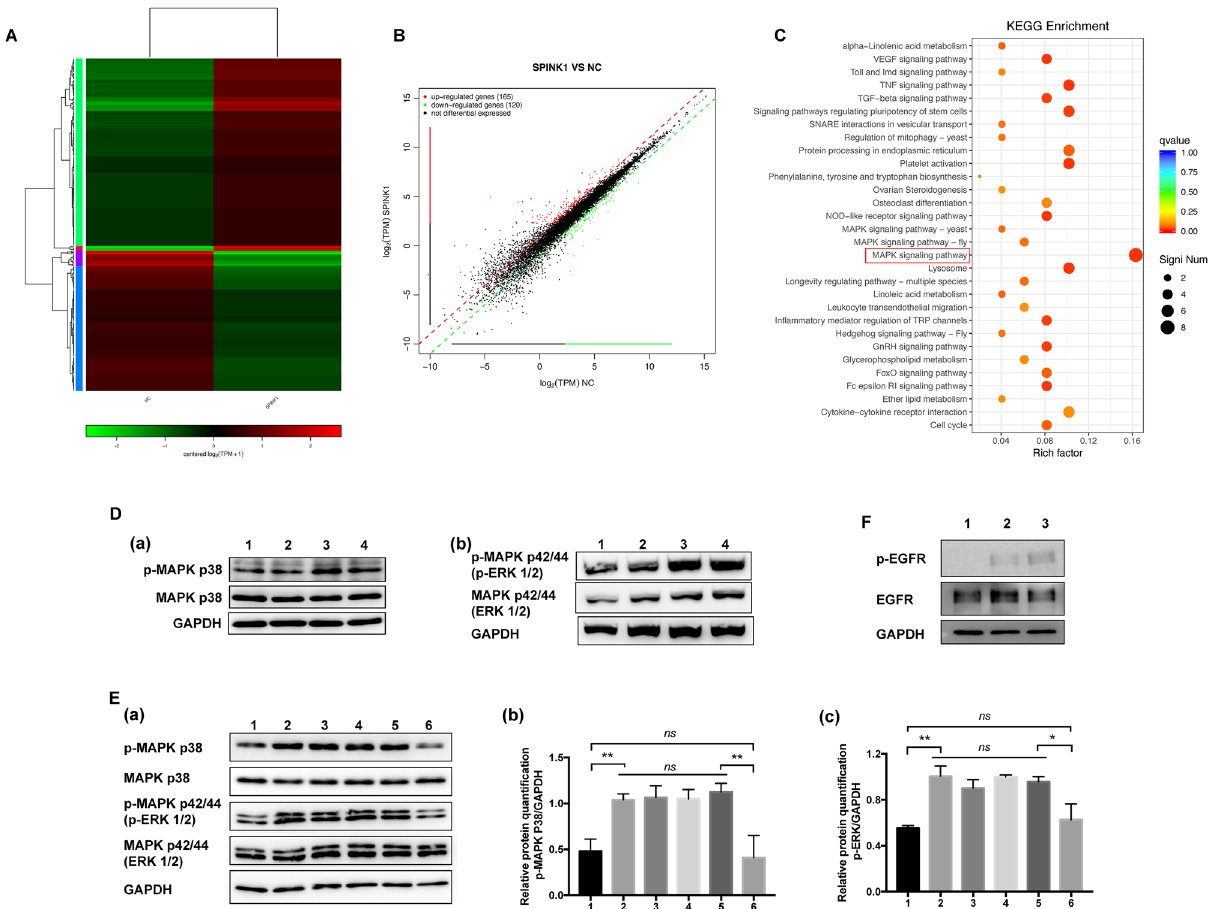
Figure 4. SPINK1 treatment alters transcriptome-wide expression of endothelial cells. ( A ) Unsupervised clustering based on differentially expressed genes (F test p ≤ 0.01). ( B ) Scatter plot representation of the comparison between low serum medium (NC)-treated and SPINK1-treated HUVECs. Genes up- or downregulated in SPINK1-treated cells relative to wild-type cells are shown in red and green, respectively. ( C ) Significantly enriched functional scatter plot (Kyoto Encyclopedia of Genes and Genomes, KEGG). ( D ) Western blot analysis of pMAPK and MAPK in HUVECs exposed to 50 ng/ml SPINK1. HUVECs were placed in serum-free media for 3 h prior to a 15 min exposure to 50 ng/ml SPINK1 (lane 3) and 30 min (lane 4) or with low serum medium alone for 15 min (lane 1) and 30 min (lane 2) as a control. ( E ) (a). IL8-dependent detection of MAPK phosphorylation. HUVECs were starved with serum-free media for 3 h, followed by 50 ng/ ml SPINK1 treatment (lane 2), 50 ng/ml SPINK1 plus anti-actin antibodies (5 µg/ml) (lane3), 50 ng/ml SPINK1 plus anti-IL-8 neutralizing antibodies (5 µg/ml) (lane4), 50 ng/ml SPINK1 plus recombinant IL-8 (10 ng/ml) (lane5), 10 ng/ml recombinant IL-8 (lane6), or low serum medium (lane 1) treatment as a control. (b) and (c). The relative protein quantification of p-MAPK/GAPDH. ( F ) Western blot analysis of pEGFR and EGFR in HUVECs exposed to 50 ng/ml SPINK1. HUVECs were placed in serum-free media for 3 h prior to a 0 min exposure to 50 ng/ml SPINK1 (lane 1), 15 min (lane2) and 30 min (lane 3). Although quantitative comparisons between samples on different blots are unavoidable, the samples derive from the same experiment and that blots were processed in parallel. The original images of all blots with three replicates are presented in Supplementary Figs. 10 and 11. Due to the blots were cut prior to hybridization with antibodies, the images of full-length blots were absent. * p ≤ 0.05, ** p ≤ 0.01, *** p ≤ 0.001, **** p ≤ 0.0001; unpaired